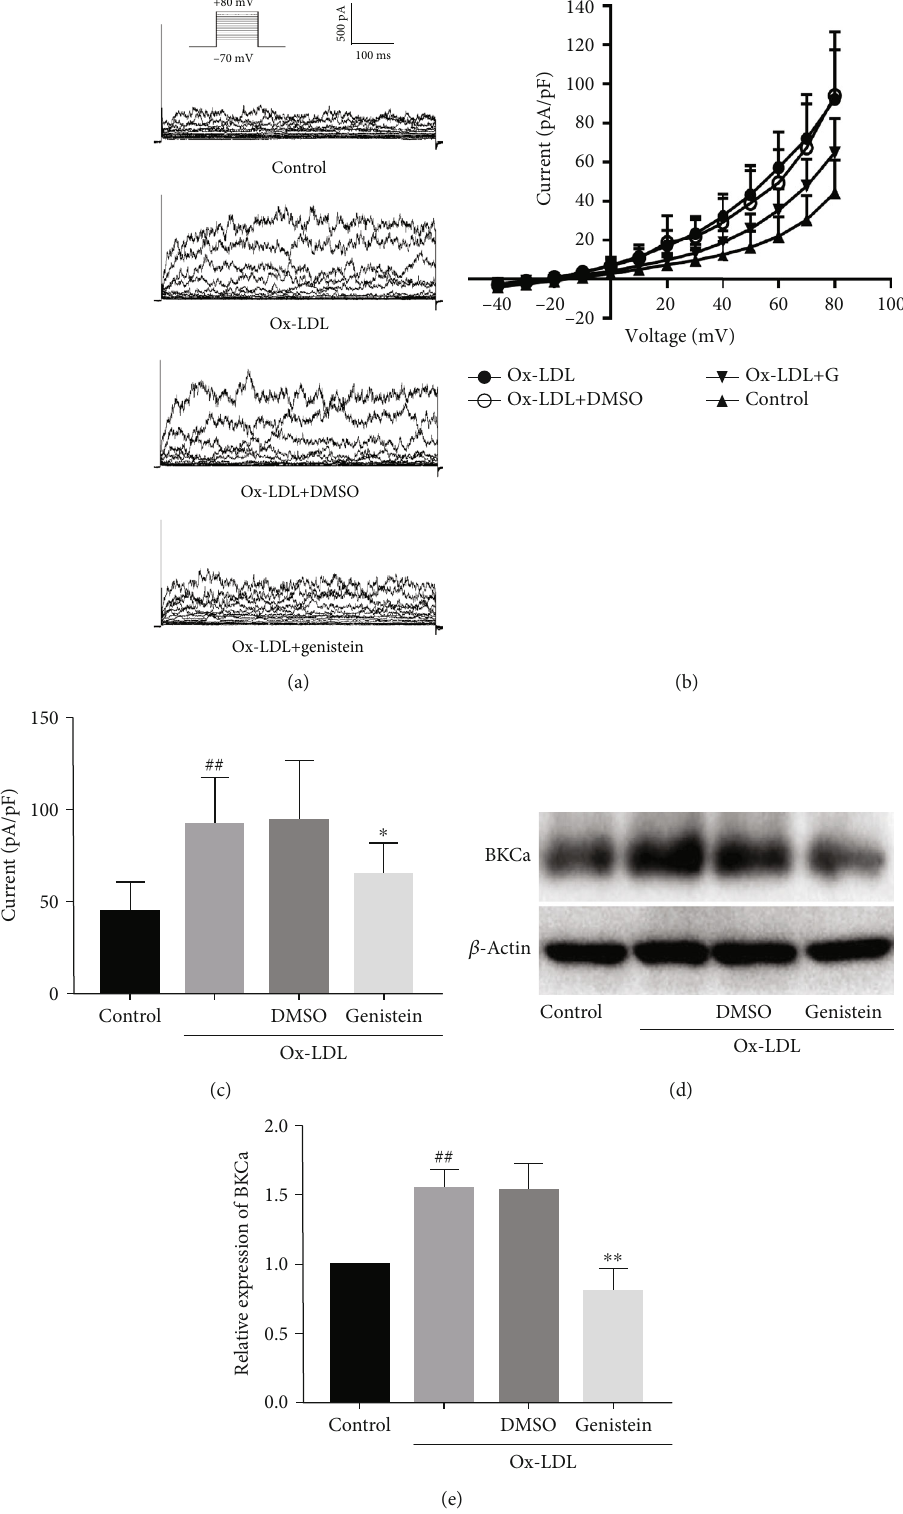
Figure 4: E ff ect of genistein on protein expression and current level of BKCa channels. (a) Representative BKCa currents. (b) I ‐ V curves of BKCa currents. (c) BKCa peak current densities at the test potential of -80 mV. ## P < 0 : 01 vs. control, ∗ P < 0 : 05 vs. Ox-LDL. (d) Western blot analysis and (e) statistical analysis of BKCa channels. ## P < 0 : 01 vs. control, ∗∗ P < 0 : 01 vs. Ox-LDL. All the results are expressed as the mean ± SD ( n = 3 ). The data indicated that genistein signi fi cantly reversed Ox-LDL-enhanced protein expression and current level of BKCa